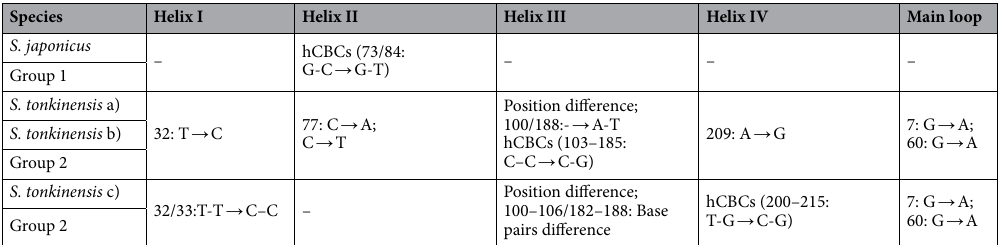
two base sites in group 2 were identical to those of S. japonicus (base sites 32 and 209), and two base sites were variable (base sites 60 and 185). Analysis of the ITS2 secondary structure. The ITS2 database was used to predict the homology of the secondary structures of 48 major species of the genus Styrax Linn. The ITS2 secondary structures of all species were folded into the typical structure of a central loop with four helices (I, II, III, and IV), with helix III identified as the longest helix, followed by helices I, II, and IV. Helix II was the most conserved, with the central main loop relatively conserved and rich in purine bases 46–48 . The ITS2 secondary structure predictions for 40 individual samples are shown in Table 4. By homology prediction, 30 samples were derived from species of the genus Styrax Linn., 16 of which were identified as S. tonkinensis and 14 as S. japonicus . In addition, 10 samples were derived from species of other genera. The ITS2 secondary structures of the two species identified as S. tonkinen- sis and S. japonicus in the benzoin samples are shown in Fig. 2A. The helix positions and angles of the secondary structures of these two species are completely different, with helices I and III identified as more variable due to multiple unpaired bases and positional differences. In contrast, the shapes of helices II and IV, although basi- cally the same, also contain unpaired bases, leading to differences. S. tonkinensis contains three slightly different secondary structures, as shown in Fig. 2A a), b), and c). The red dashed boxes represent the base pairs between the base of helix III and the first unpaired loop on the helix arm of S. tonkinensis a) and S. tonkinensis b), and